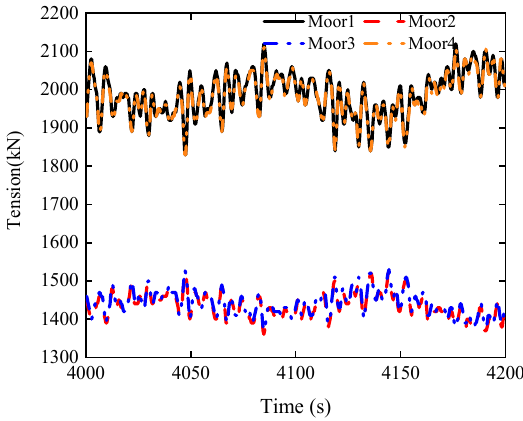
Figure 8. Time histories of mooring lines tension at EC2.